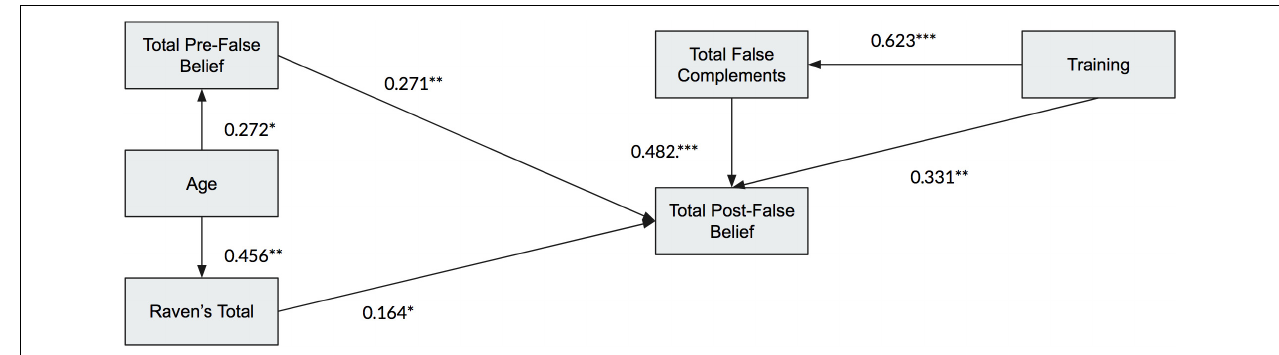
FIGURE 8 | Standardized parameter estimation for the hypothesized